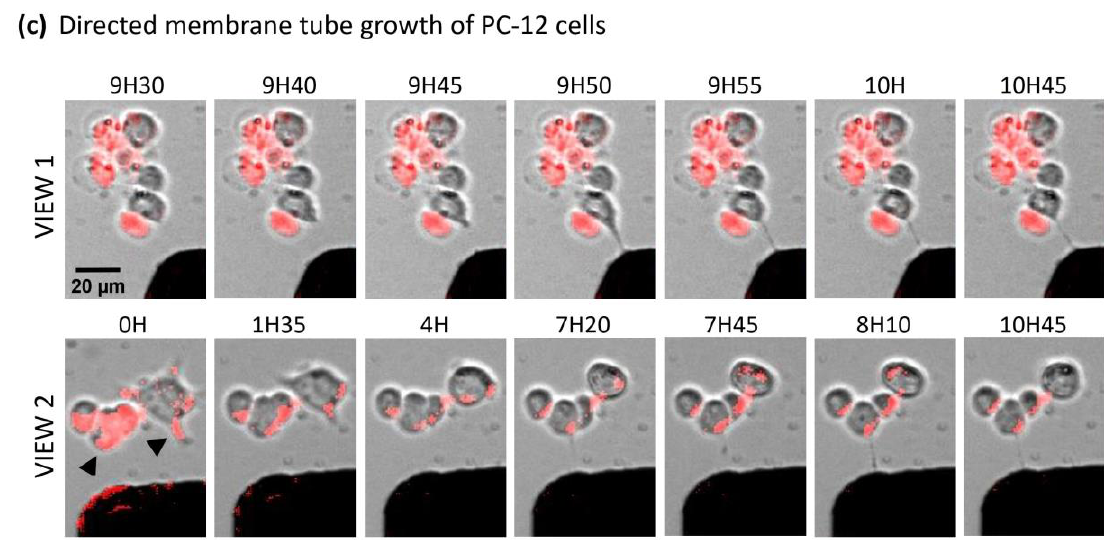
Figure 4. Towards the parallelized magnetic manipulation of neurite outgrowth. ( a ) Images of cortical neurons loaded with magnetic nanoparticles (in red) during 24 h of magnetic attraction. At time 0 h, the black arrows show two neurons containing magnetic particles. At 2 h 10 min, a protrusion formed towards the pillar and co-localized with the particles’ enrichment region (red dot). At 2 h 25 min, this same cell (left) polarized and migrated towards the magnetic pillar. The speed of the displacement was estimated to be 190 µ m / h. At 3 h 30 min, the right cell polarized, exhibiting the characteristic triangular shape preceding cell migration or axonal growth. From 3 h 50 min to 4 h 10 mins, a neurite form lengthened and aligned with the movement of the cell towards the pillar. At 4 h 25 min, the cell completed its movement against the pillar. The movement speed was estimated to be 30 µ m / h. ( b ) Images of cortical neurons loaded with magnetic nanoparticles (in red) placed under a magnetic field for 72 h. Among 22 pillar positions, one single neuron, shown by the black arrow, displayed a directed neurite outgrowth towards the micro-pillar without cell migration. At 35 h, a tube with MNPs at its tip formed very quickly and briefly toward the magnetic pole, before vanishing. At 38 h 10 min, we observed a neurite growth towards the micro-pillar at a speed of 120 µ m / h with the presence of MNP accumulation (red spot) at the tip, touching the magnetic pole. The elongation was followed by the thickening of the neurite, which remained in place for 18 h with good viability of the neuron and despite the cellular body deformation due to the strong pulling. ( c ) Images of PC12 cells, loaded with magnetic nanoparticles (in red), treated for 5 days with nerve growth factor (NGF), during 24 h of magnetic attraction. Several cells displayed neurite-like tubes growing directionally towards the micro-pillar and loosely attached to the surface. Two of them are shown in this figure in views 1 and 2 (see left black arrow in view 2). Multiple cells with MNP accumulation in the tip of spontaneous minor processes showed retraction of the fiber, rather than elongation. One event is shown in View 2 (right black arrow).